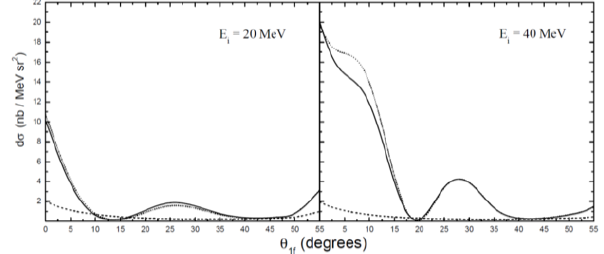
Figure 1: Bremsstrahlung cross section for different values of incident energies E and for photon energy E γ = 1 MeV: calculated for potential by Buck et al. [ 14 ] (solid curve) and potential by Ali Bodmer [ 15 ] (dotted). The pure Coulomb contribution is shown by the dashed